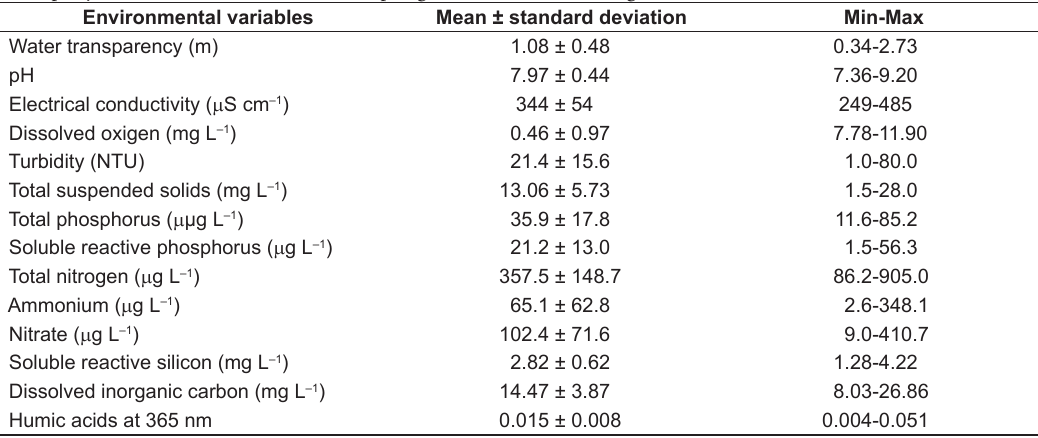
Table 1. Mean ± standard deviation and minimum and maximum values of environmental variables sampled four times per year (2010 and 2011) at 19 sampling stations in Lake Mangueira, Rio Grande do Sul, Brazil. Environmental variables Mean ± standard